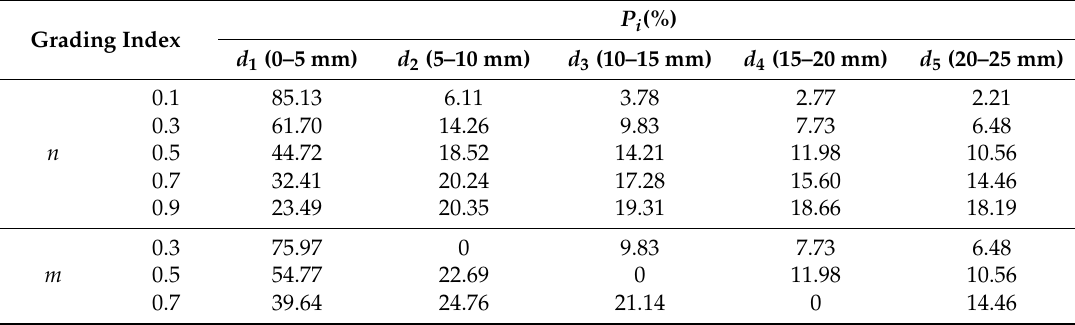
Table 1. Proportion of particles in different grading index samples.